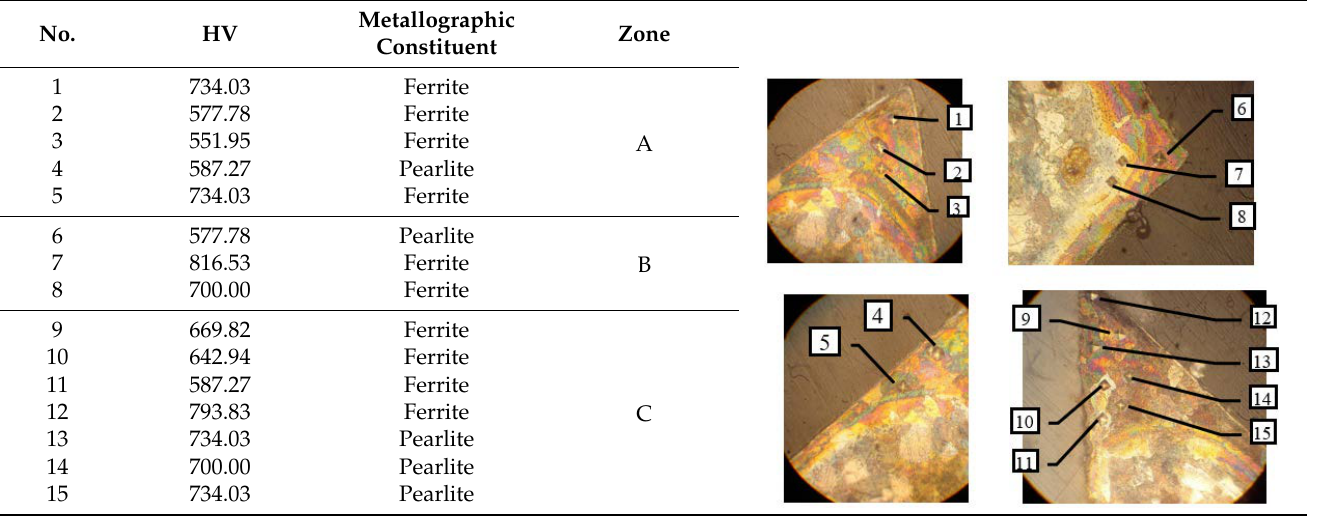
Table 3. Microhardness values of the metallographic constituents in areas A, B, and C along with the images of the marks measured for the nitrided sample without a screen.